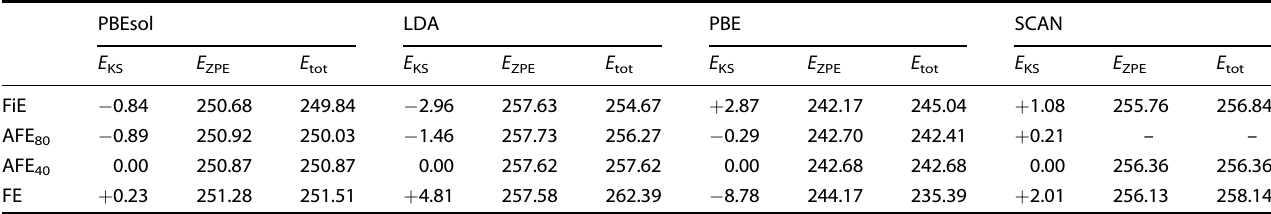
For each exchange-correlation functional we display the Kohn – Sham energies relative to the AFE 40 phase ( fi rst column of each block), zero-point energy (second column of each block), and sum of Kohn – Sham energies and zero-point energies ( E tot = E KS + E ZPE , third column of each block). The zero-point energy for the AFE 80 phase was not considered with SCAN (see text).